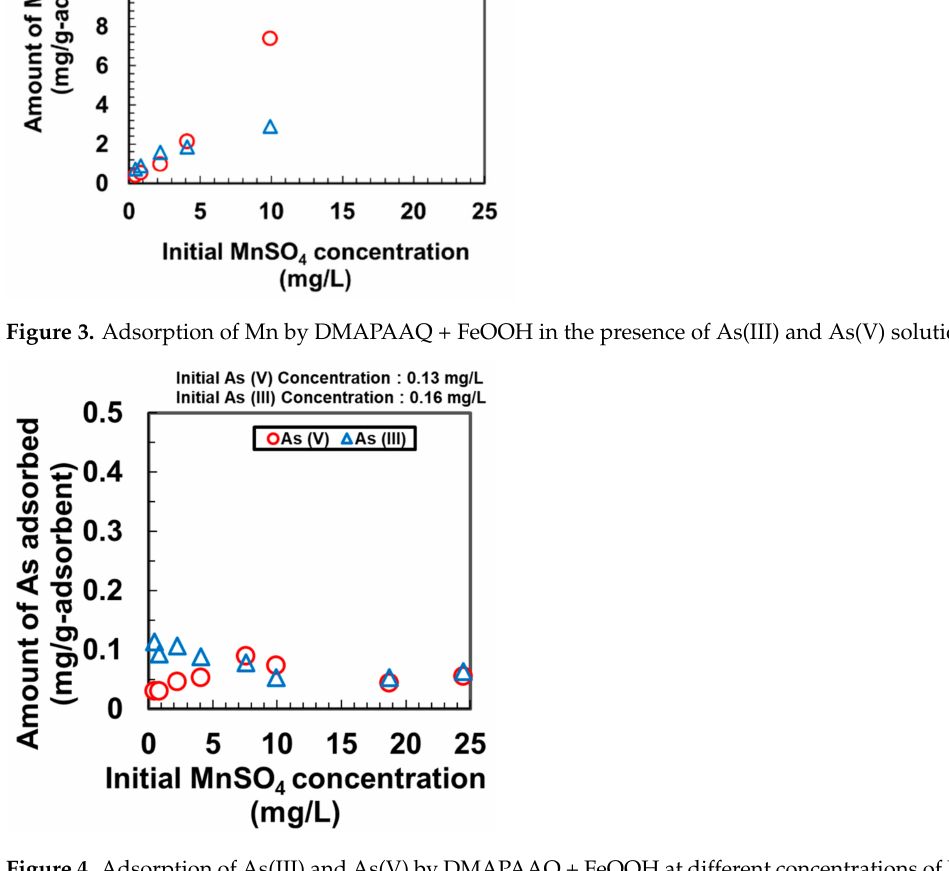
Figure 4. Adsorption of As(III) and As(V) by DMAPAAQ + FeOOH at different concentrations of